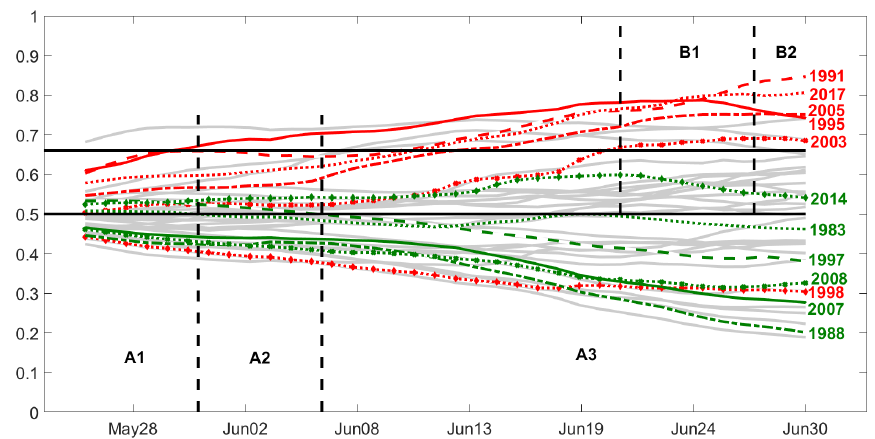
Figure 9. Temporal evolution of P exc (ψ) during the pre-fire season (26 May to 30 June). Severe (weak) years are identified by the red (green) curves. The black horizontal lines represent thresholds used in Type A ( P exc = 0 . 5) and Type B ( P exc = 0 . 66) decisions. Vertical dashed lines delimit the phase where Type A and Type B decisions were checked.